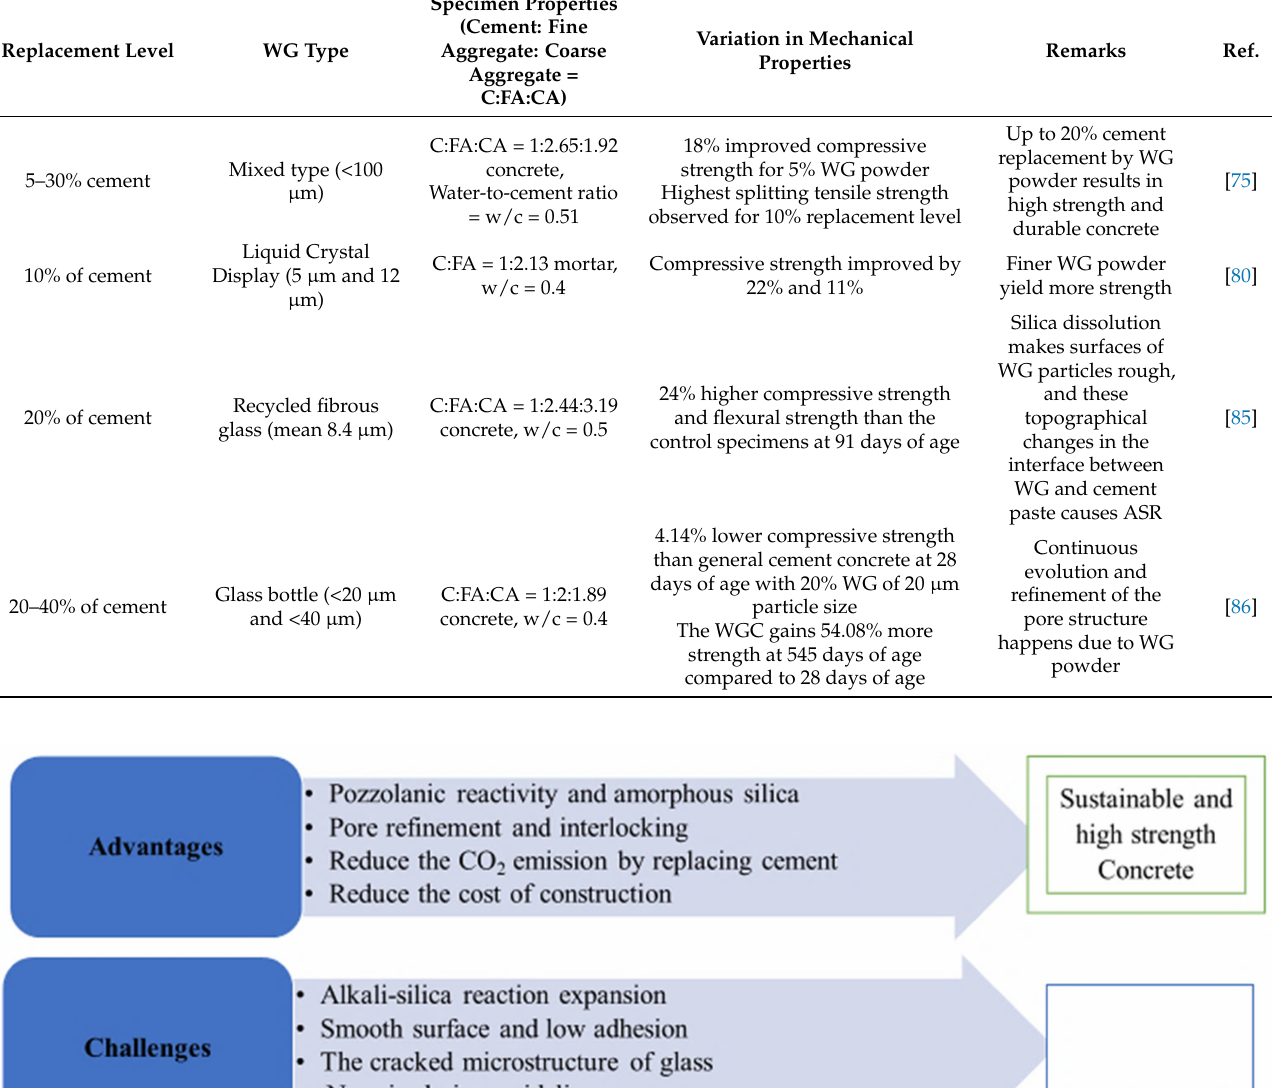
Table 2. Summary of the mechanical properties of concrete with WG as SCM.